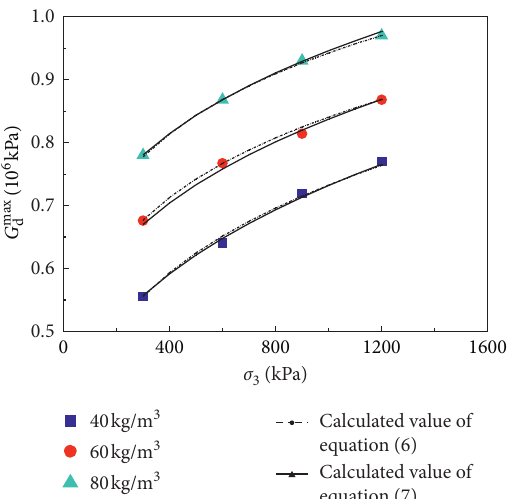
Figure 7: Relation between G max and σ 3 under different cementing d agent contents. Table 2: Parameters k ′ and n with varying cementing agent